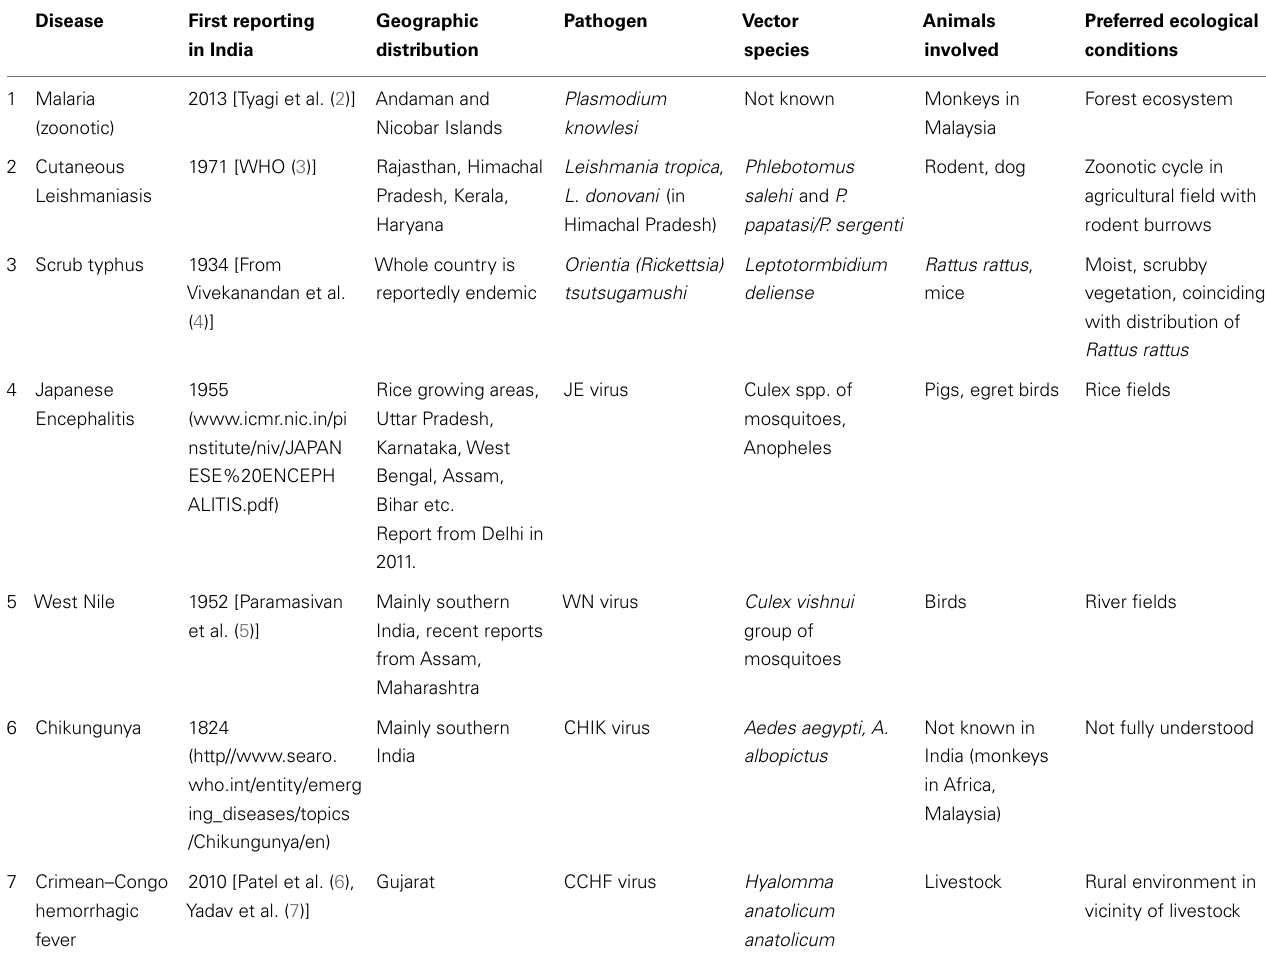
Table 1 | Major emerging/re-emerging zoonotic diseases in India